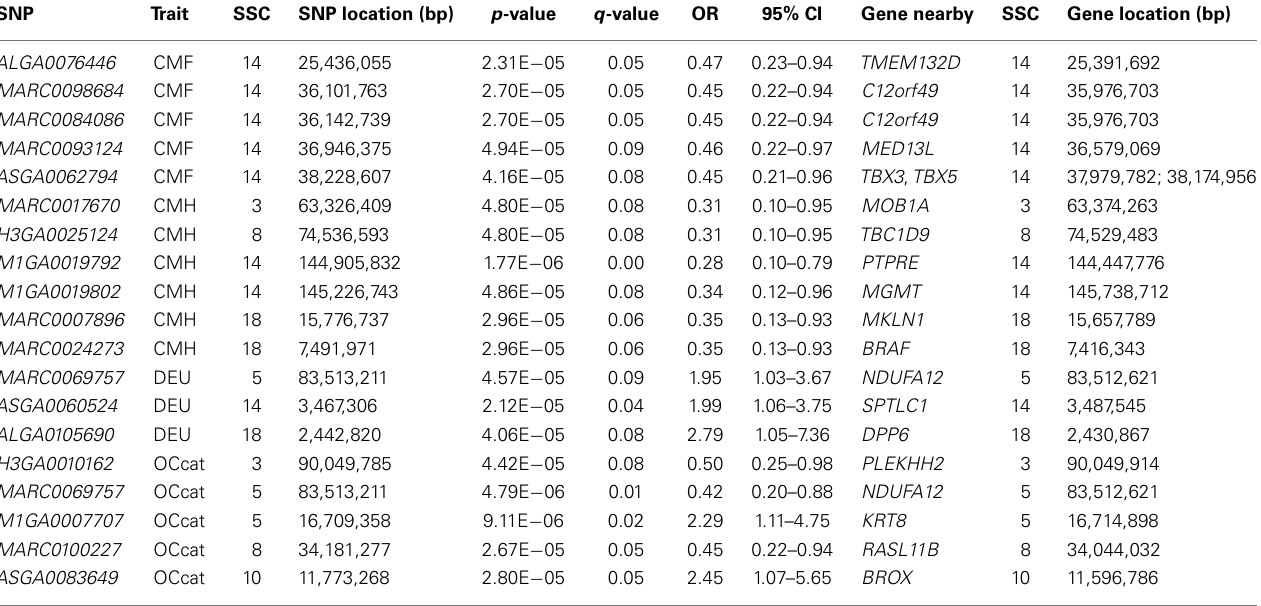
Table 3 | SNPs associated with OC lesions scores according to